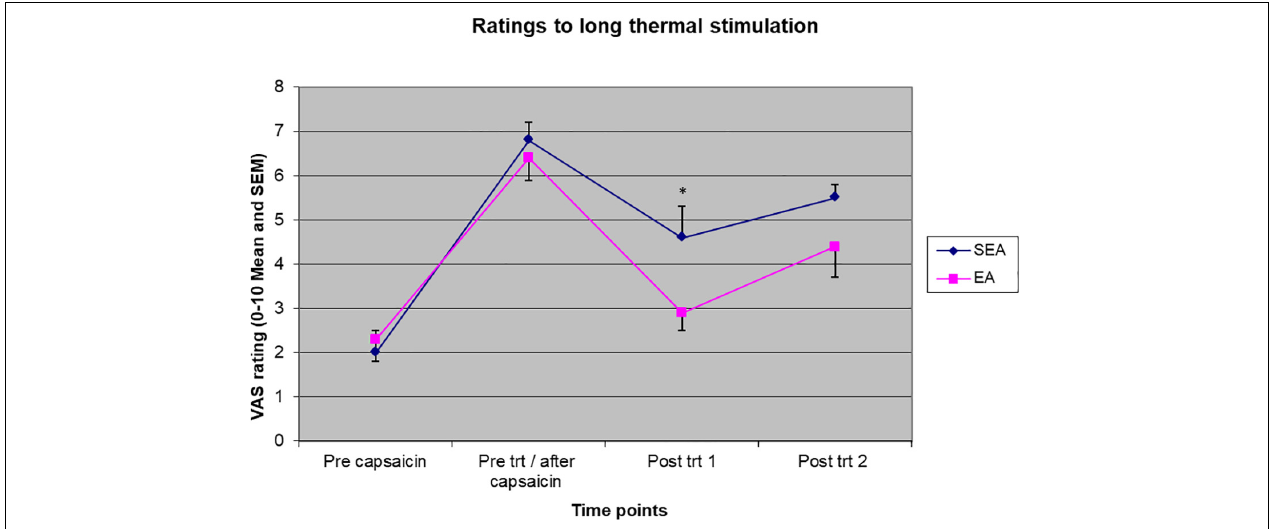
FIGURE 5 | Visual analogues scales pain rating to long thermal stimulation before capsaicin, before intervention/after capsaicin (Pre trt/after capsaicin), immediately after (Post trt 1), and 90 min after (Post trt 2) intervention in REA and SEA groups. Data are expressed as mean ± SEM. ∗ indicates statistically significantly difference between EA and SEA, p < 0.05.